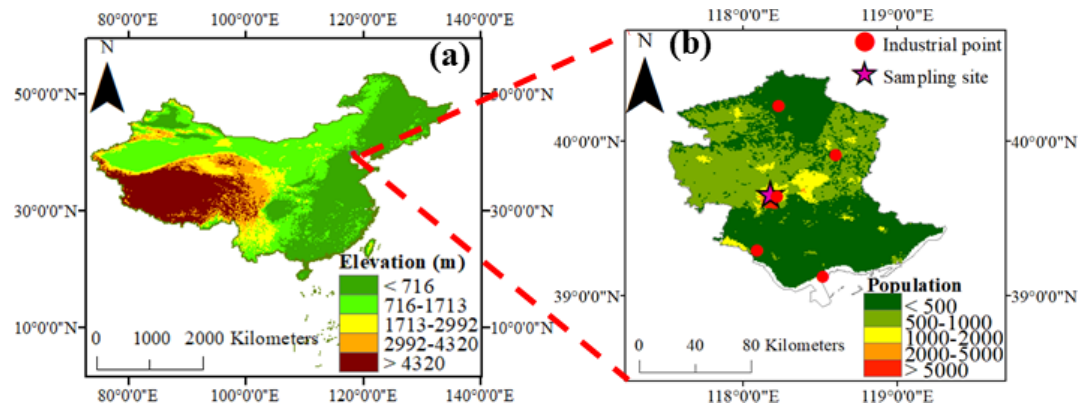
Figure 1. The topographic map of China indicating the location of Tangshan (a) , sampling site (b) , and some key industrial points (b) . The population density of Tangshan is also depicted in (b) . The red circle in (b) represents the industrial points, and the pink pentagram denotes the sampling